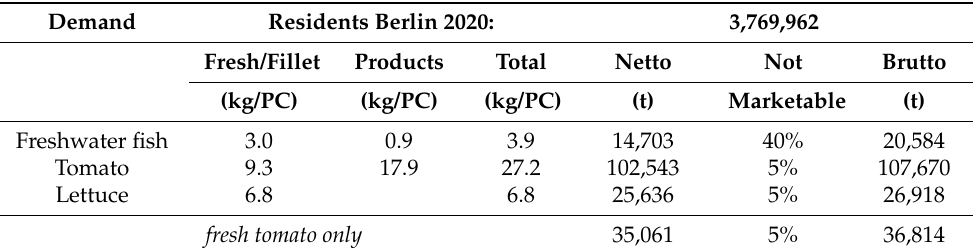
Table 2. Annual metropolitan Berlin demand for freshwater fish/fish products, tomatoes/tomato products (converted to fresh weight), and lettuce.